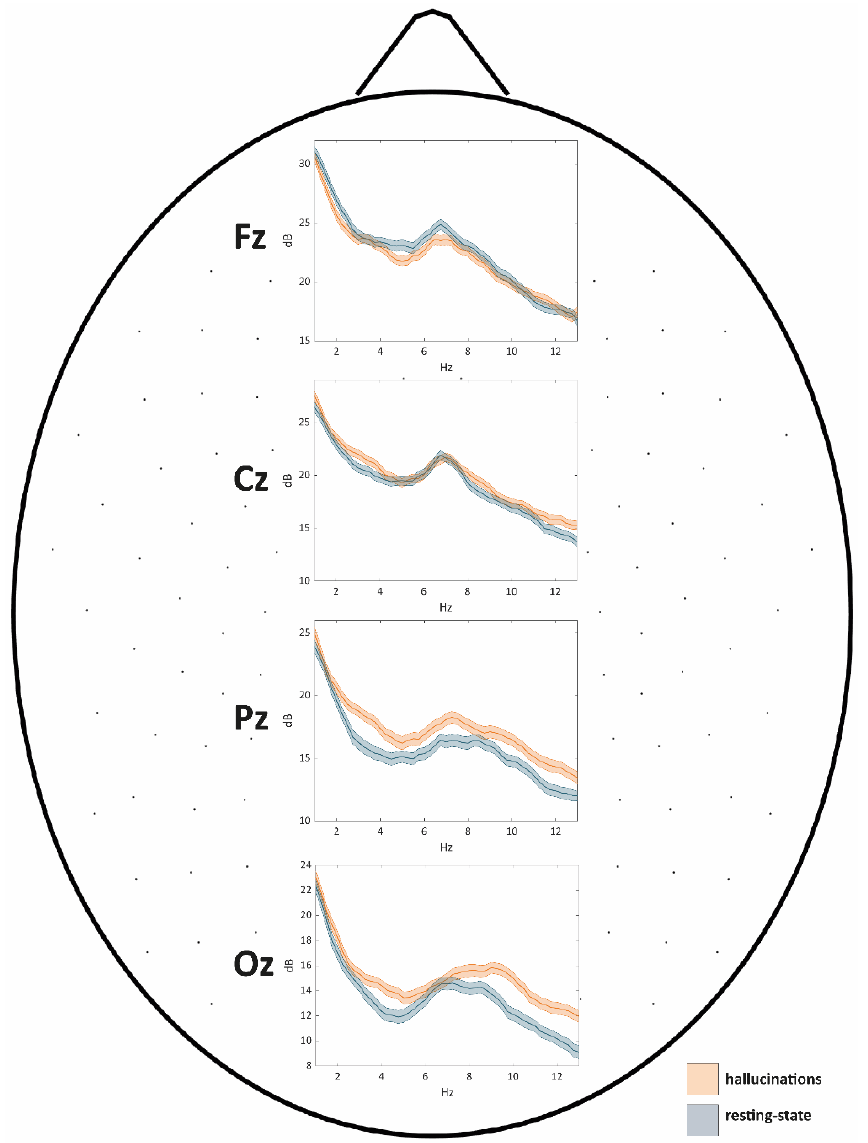
Figure 2. The PSD of VH and RS conditions are presented as a function of frequency for four representative electrodes. In each subplot, the solid line represents, for each condition, the mean PSD value, whereas the colored areas highlight the values enclosed between the mean-standard error and mean + standard error interval.